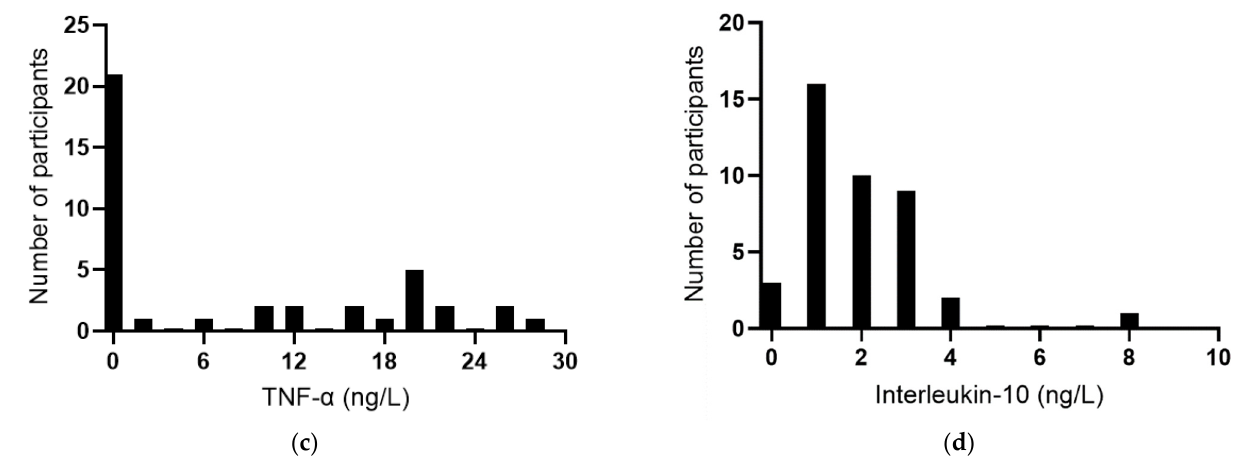
Figure 3. Baseline inflammatory biomarker status in the study cohort. Frequency distributions of: ( a ) C-reactive protein ( n = 60), ( b ) interleukin-6 ( n = 41), ( c ) tumour necrosis factor-alpha (TNF- α ; n = 40), and ( d ) interleukin-10 ( n = 41).